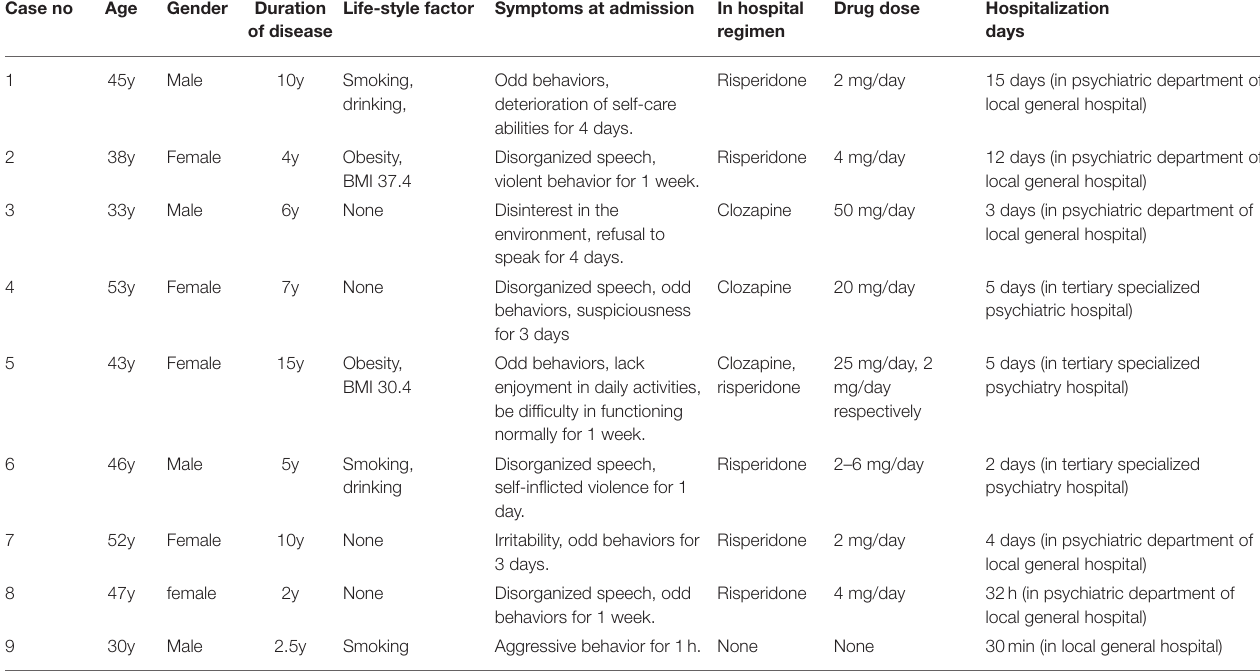
TABLE 1 | Clinical and demographic information of the patients ( n = 9). Case